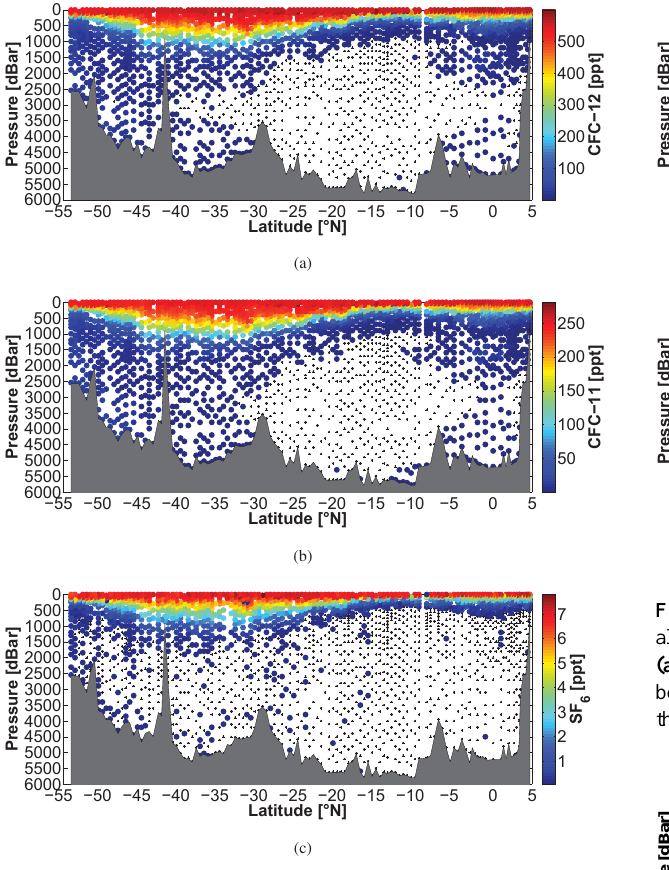
Figure 11. Transient tracer concentrations of the CLIVAR A13.5 section along the Greenwich Meridian in 2010 of ( a ) CFC-12, ( b ) CFC-11 and ( c ) SF 6 in ppt . The black dots indicate measurements with concentrations below the detection limit. Figure 13. Salinity section of the CLIVAR A13.5 section along the Greenwich Meridian in 2010. The black dots indicate data within the application range of the IG-TTD (i.e. constrainable data points). The IG-TTD limiting SAF can be identified by the salinity drop at 46 ◦ S and the AAIW by the low salinity layer originating south of the SAF.